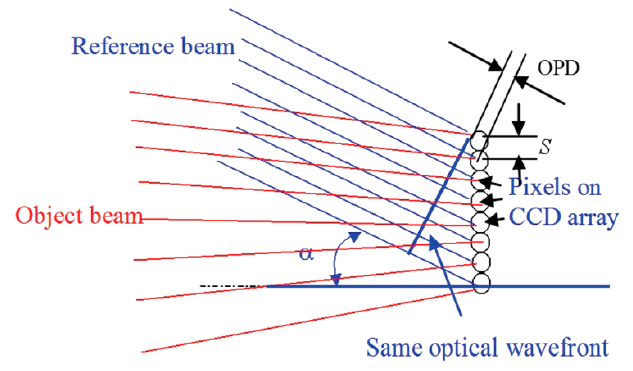
Figure 5. Schematic of single-detector spatial phase-shift technique.